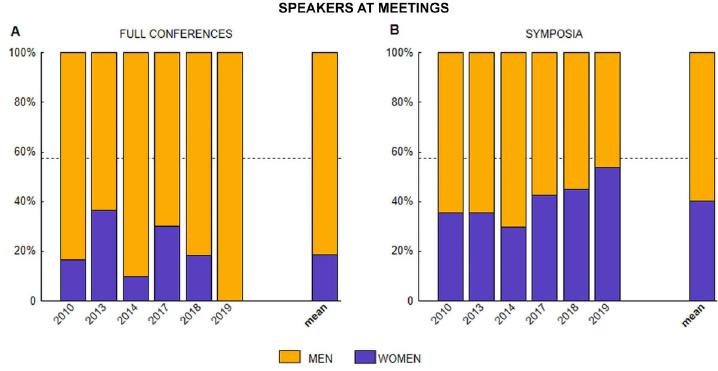
Figure 2. Speakers at full conferences ( A ) and at symposia ( B ) in six national and stand-alone meetings of the Brazilian Society of Neuroscience and Behavior (SBNeC). Dashed lines indicate the mean percentage of senior women members (57.50%) between 2010 and